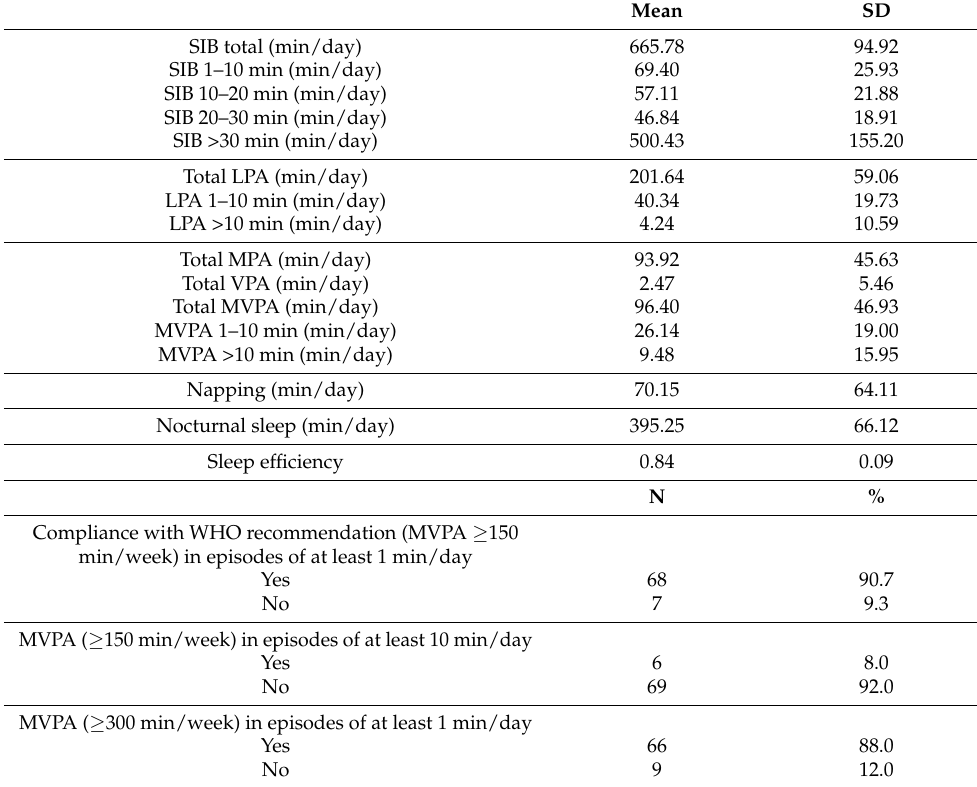
Table 2. Accelerometry outcomes in the family caregivers (n = 75).